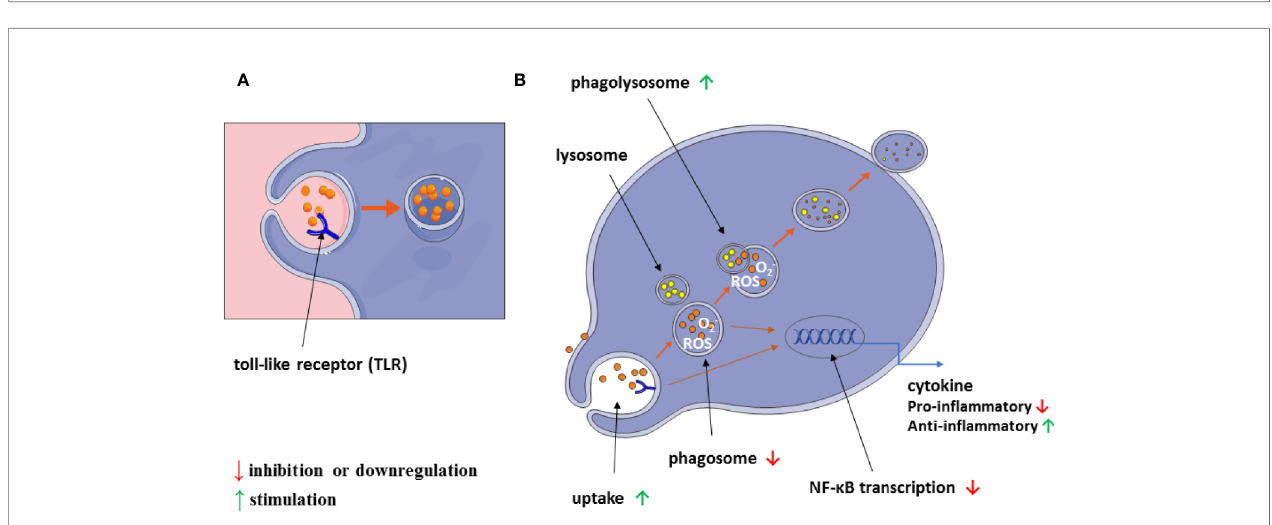
FIGURE 10 | Scheme of alantolactone in fl uence on macrophage immunomodulatory and in fl ammatory properties (A, B)